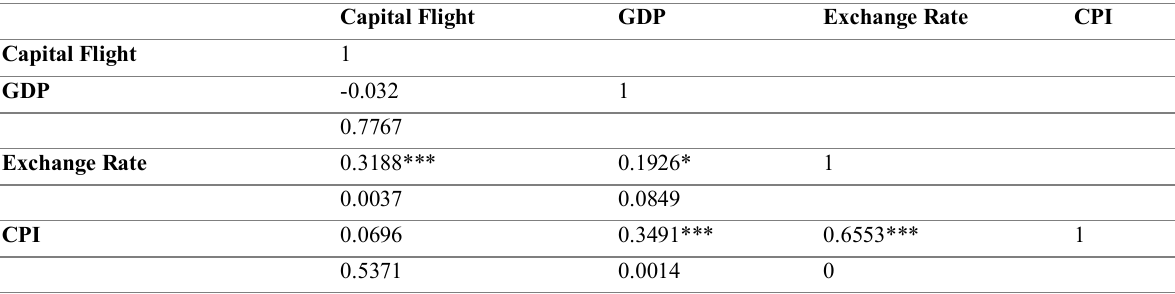
Table 3: Correlation coefficients between variables